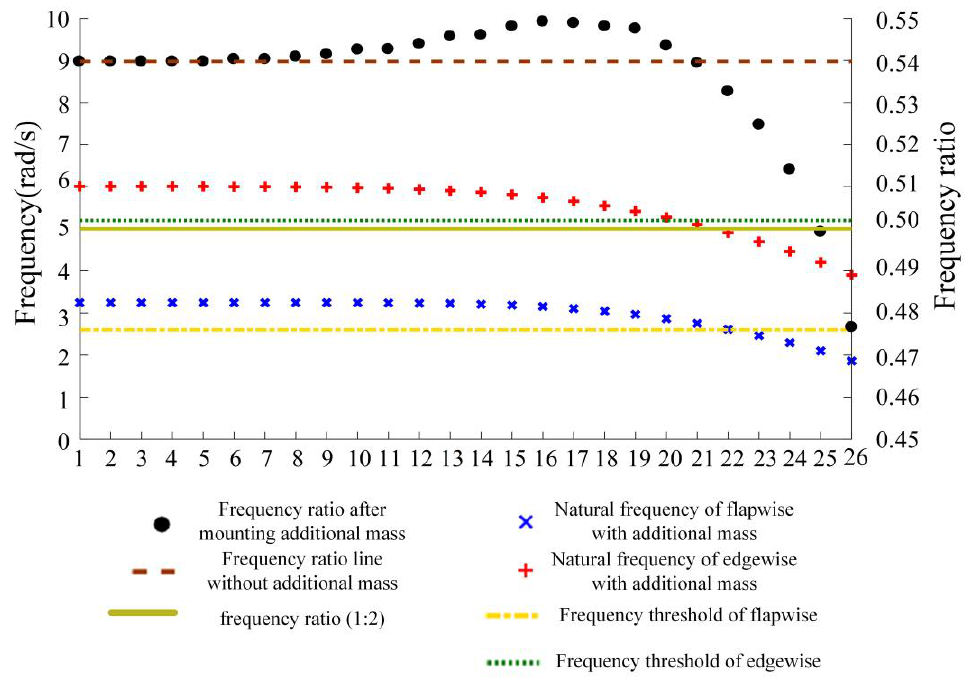
Figure 29. Natural frequency and frequency ratio of the system when the mass block with the same mass is installed at different positions of the blade.